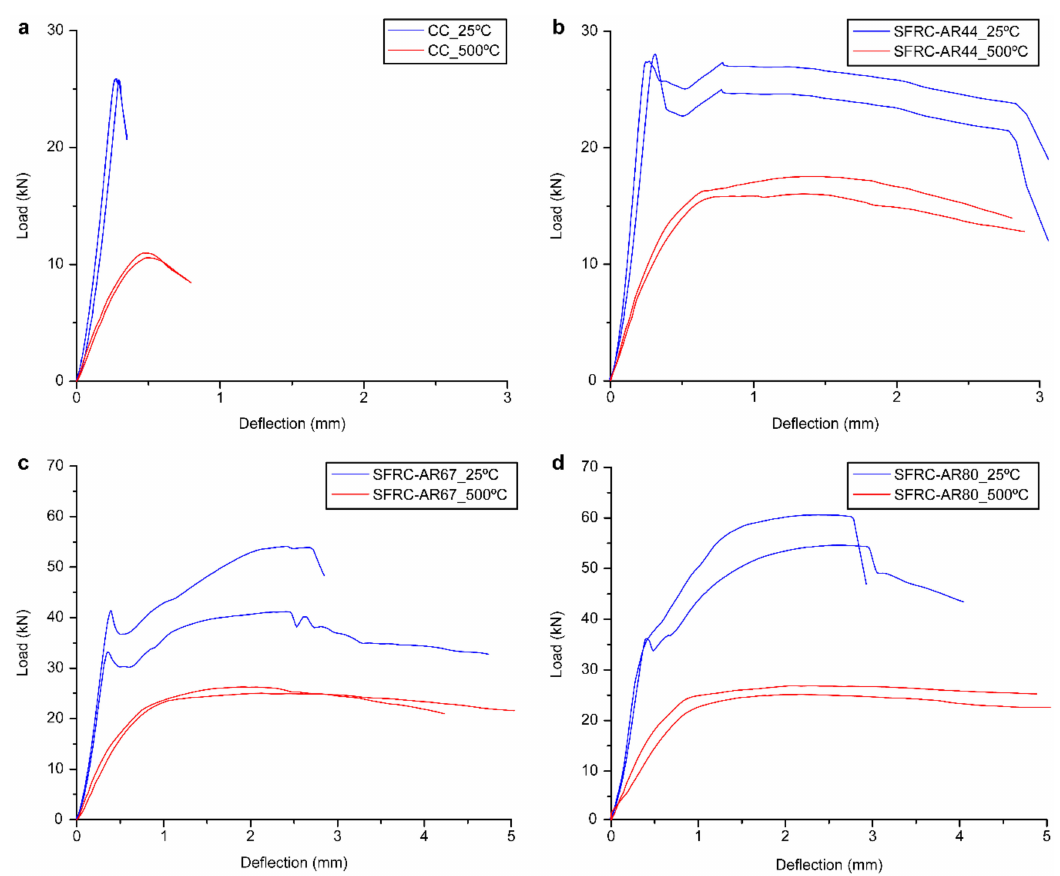
Figure 7. Load–deflection curves recorded for various concrete specimens for flexural tests. ( a ) CC; ( b ) SFRC-AR44; ( c ) SFRC-AR67; and ( d )